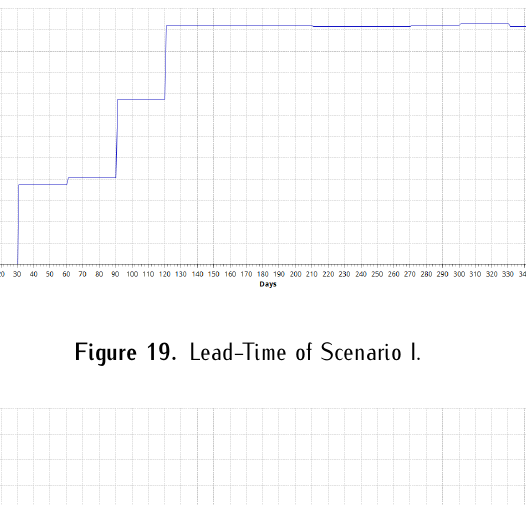
Figure 18. Available Inventory of Scenario I.